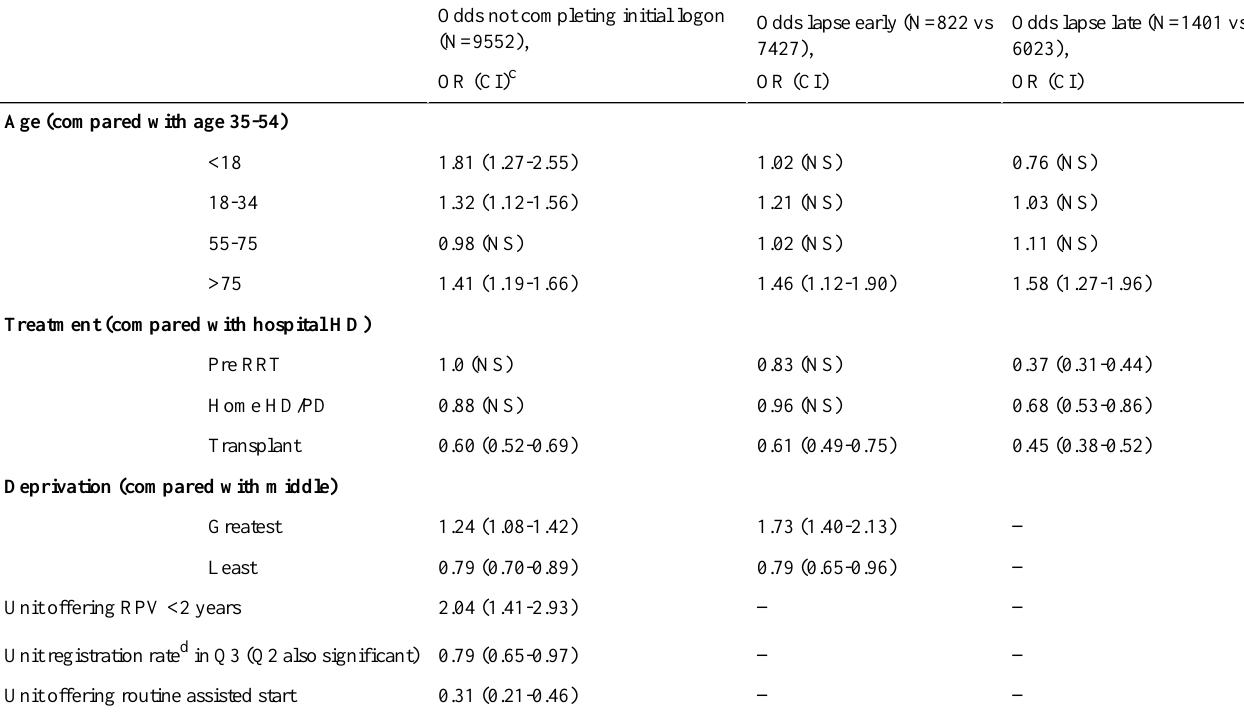
Table 4. Odds of not persisting with RPV use at proposed hurdles a,b